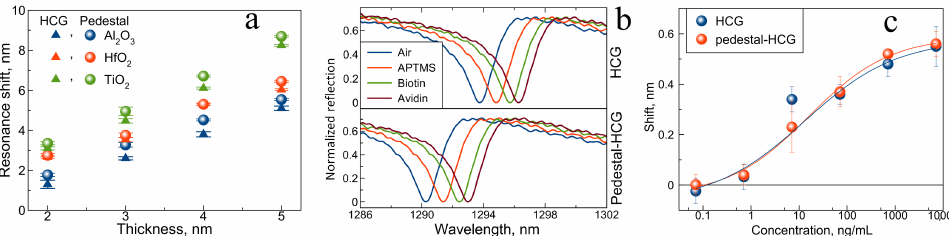
Figure 5. ( a ) Position of the resonance for the HCG (triangles) and the pedestal-HCG (spheres) as a function of deposited thicknesses of Al 2 O 3 (blue), HfO 2 (red) and TiO 2 (green), ( b ) reflectance spectra of the HCG (top part) and the PHCG structure (bottom part) after each of the functionalization steps, ( c ) measured resonance shifts for avidin molecule detection in PBS for the conventional (blue) and pedestal (red) HCGs.